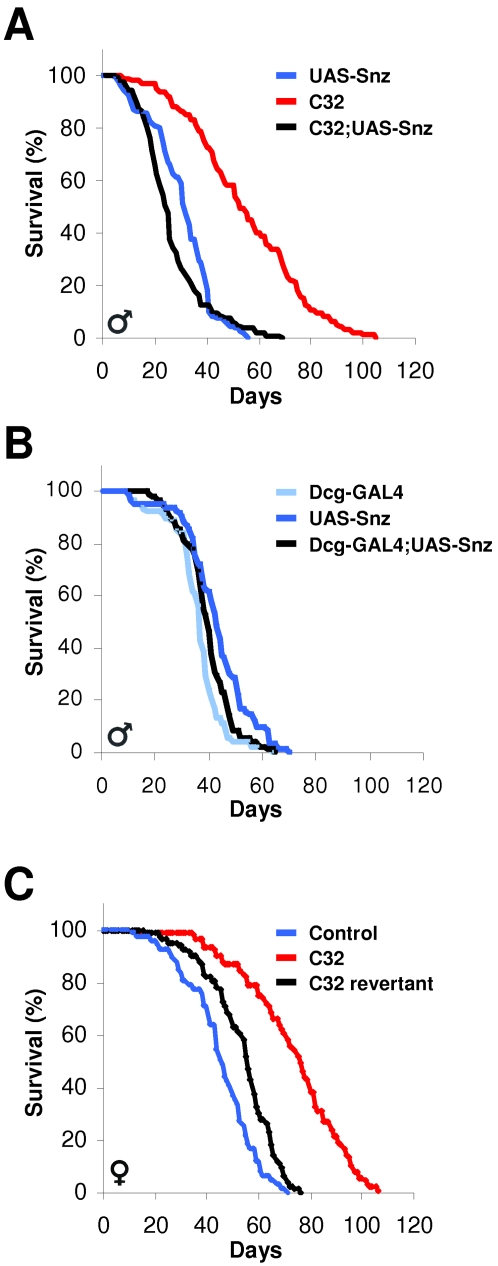

Snz Transgenesis and C32 Excision Reduces Lifespan Extension.(A) The lifespan of male control, C32, and C32; UAS-Snz transgenic flies was plotted. (n>80, p<0.0001 by log-rank test between C32 and C32; UAS-Snz ) (B) The lifespan of male Dcg-GAL4, UAS-Snz, Dcg-GAL4;UAS-Snz transgenic flies were plotted. (n>80) (C) Female control, C32, and C32 revertant flies were cultured and survival was plotted. (n>80, p<0.0001 by log-rank test between C32 and C32 revertant) The lifespan of the male excision lines also reverted towards normal. Representative data from multiple experiments is shown.